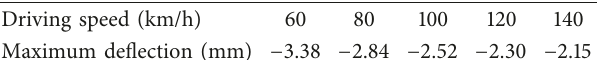
Figure 15: Comparison of the vertical displacement under different driving speeds. (a) Variation under different loading cycles and (b) variation along the transverse direction Z of the pavement. Table 10: The maximum surface deflections due to different driving speeds after loading cycles of 1 × 10 6